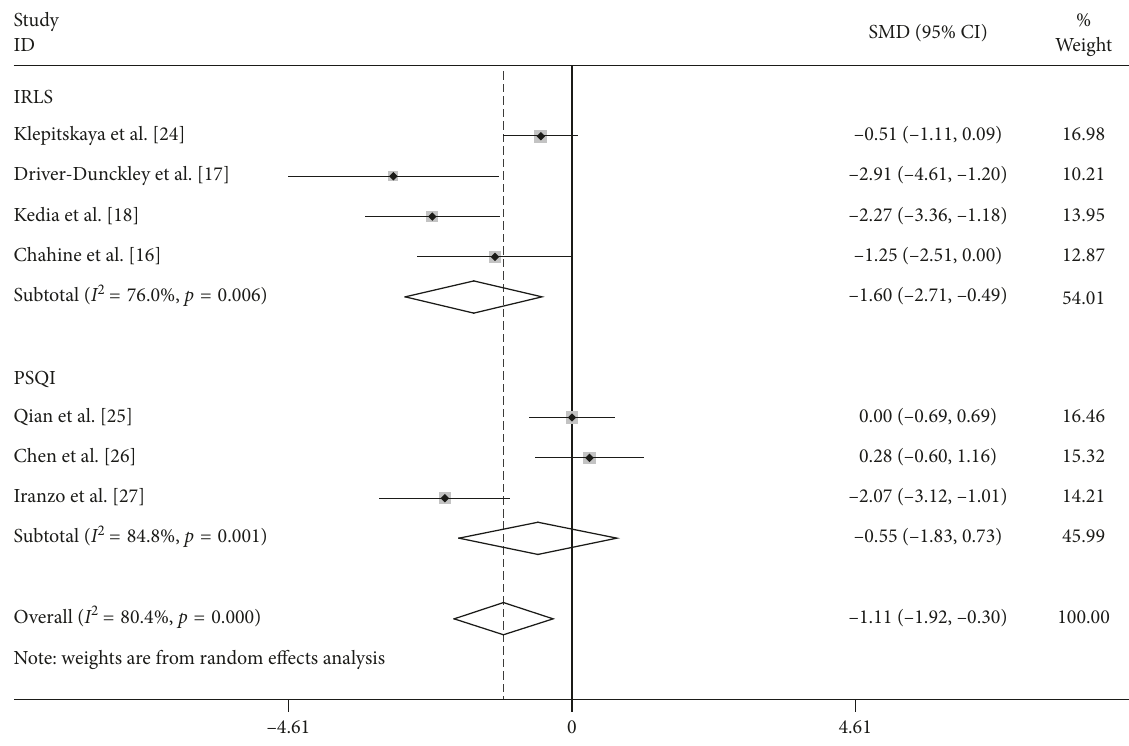
Figure 3: Subgroup analysis of the efficacy of STN DBS in the treatment of patients with RLS and sleeping symptoms.